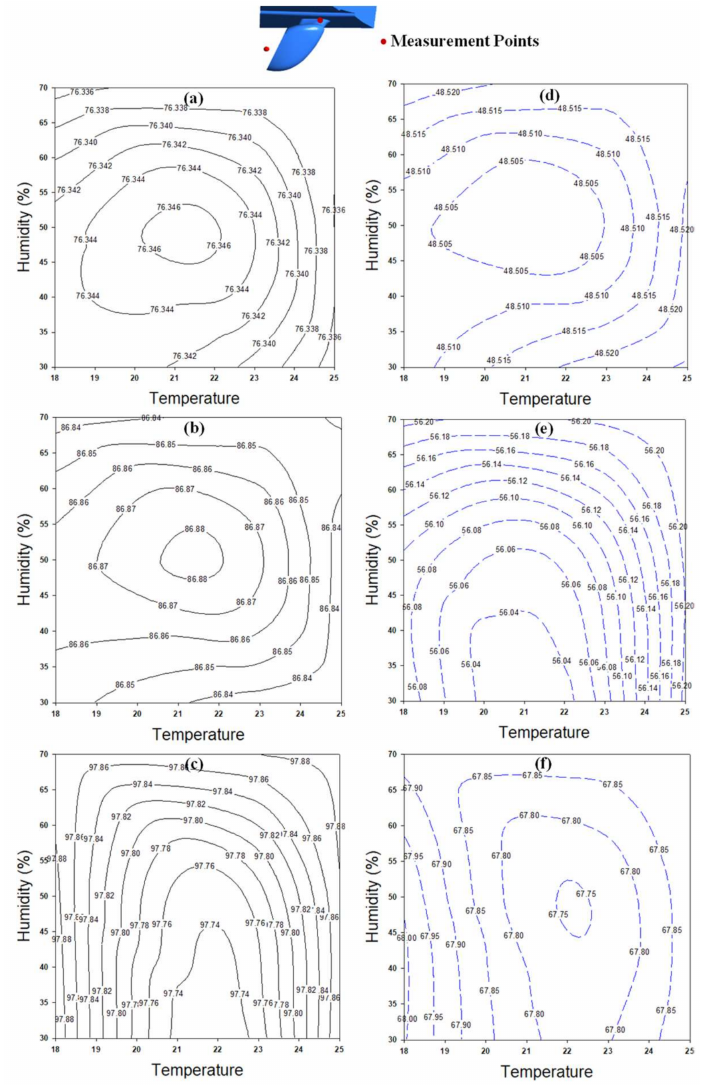
Figure 4. The graph chart of the sound pressure level of the reference OSRVM model for various relative humidities and temperatures: the gutter from ( a – c ) and the surface of the mirror from ( d – f ) for three speed cases of 60 kph, 80 kph, and 110